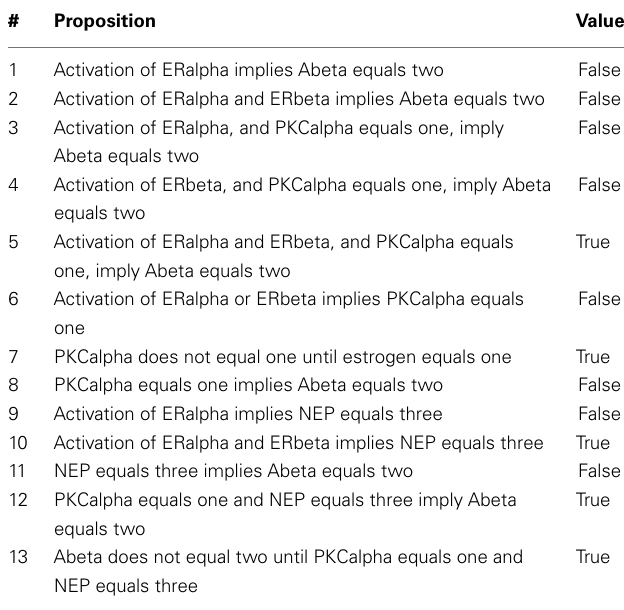
Table 3 | Using temporal-logic to check the model in the presence of CVD when estrogen , NSAID , and HIFblock , but not caspBlock , are